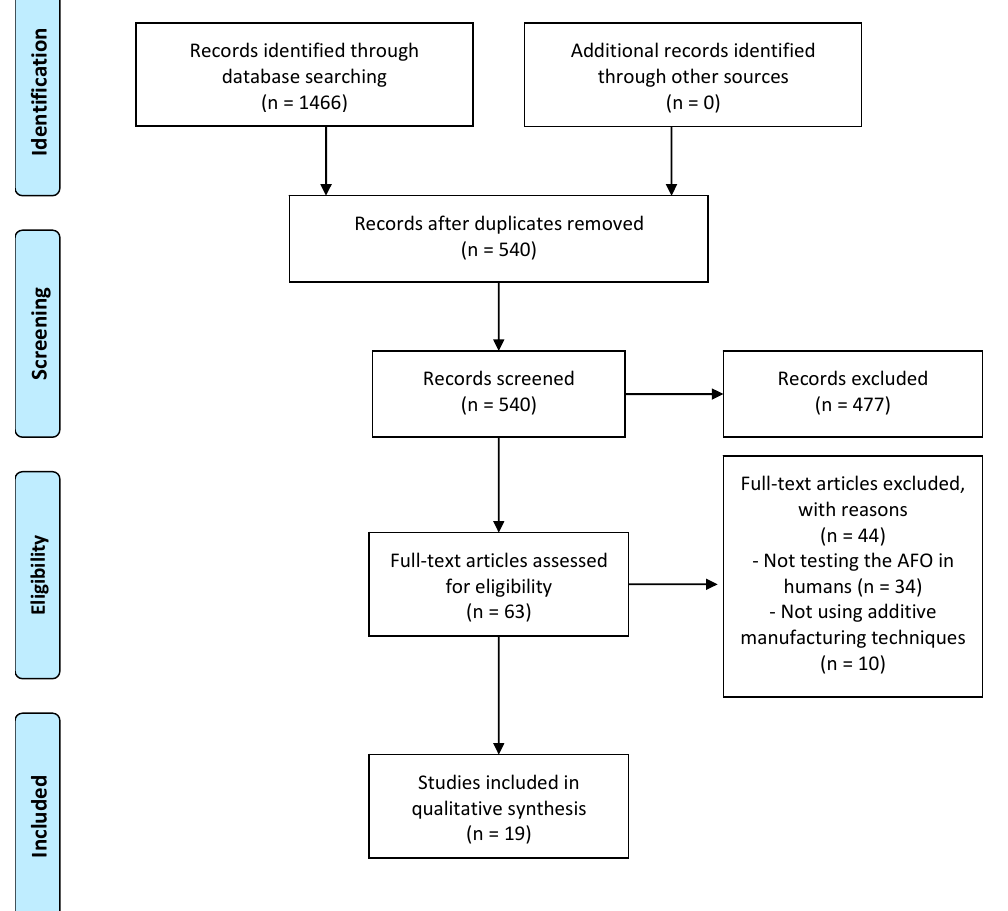
Figure 1. Flow diagram of the search history and selection process.